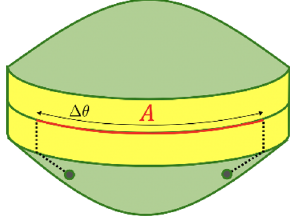
Figure 25 . We consider a non-trivial configuration of quantum extremal surfaces in the discon- nected